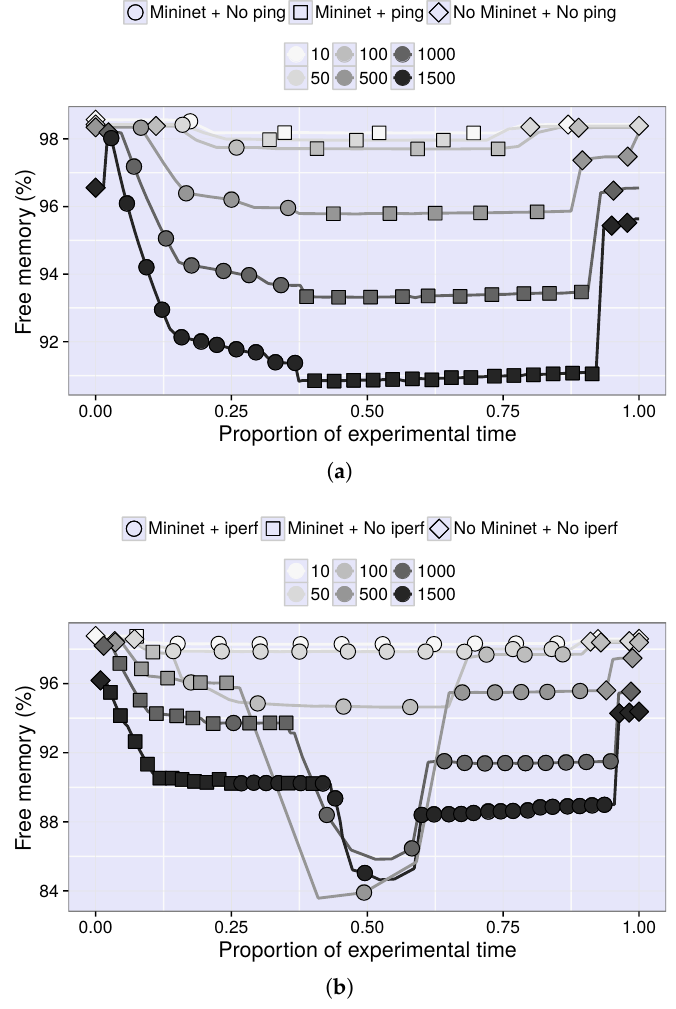
Figure 4. Percentage of free memory in terms of number of hosts, 10 switches. ( a ) Low network activity; ( b ) high network